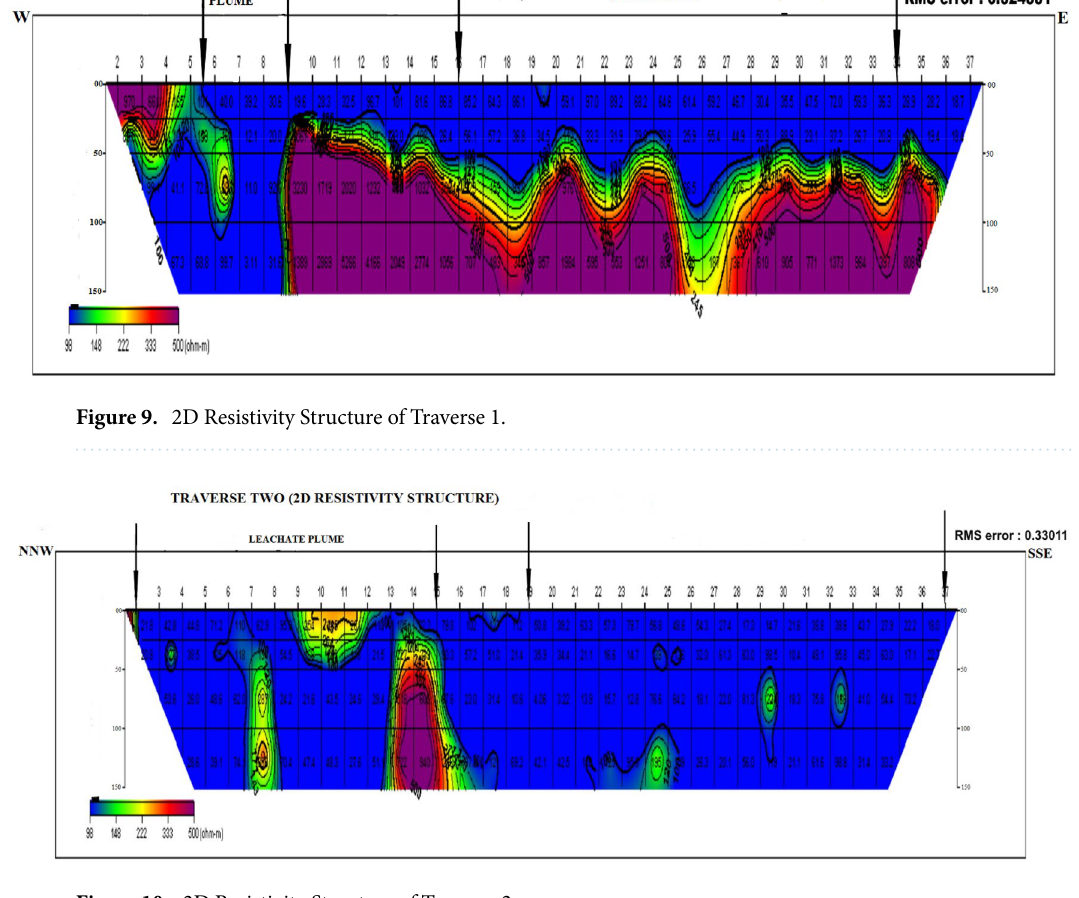
Figure 10. 2D Resistivity Structure of Traverse